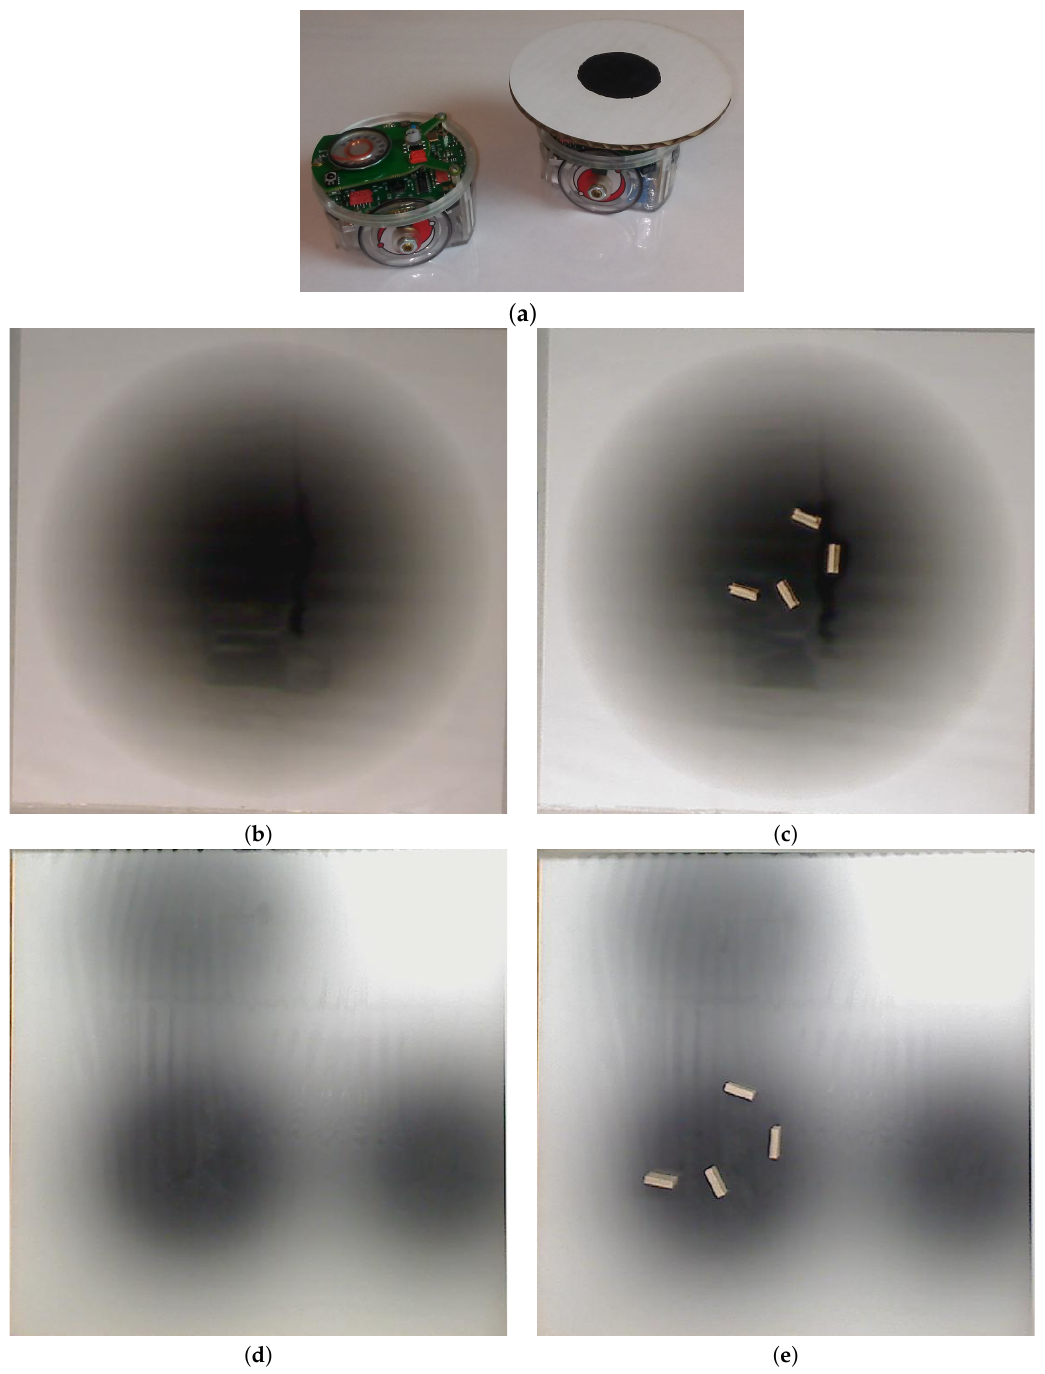
Figure 4. The e-puck robot used in the experiment can be seen in ( a ), with and without the “lid” used to make localization easier. The robots were tested on a grayscale gradient poster. Tests were done ( b , d ) without additional obstacles and ( c , e ) with obstacles in the middle of the poster. ( b , c ) represent the single-effluent environment while ( d , e ) represent the triple-effluent